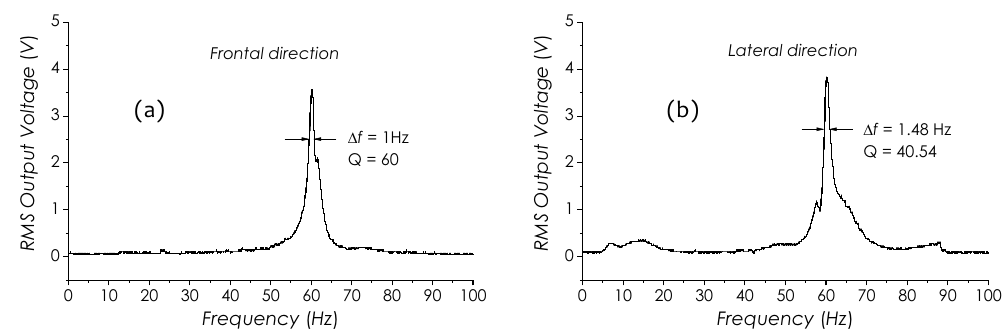
Figure 8. Frequency responses of sensor in 0 ∼ 100 Hz in mutually perpendicular directions, ( a ) frontal and ( b ) lateral.